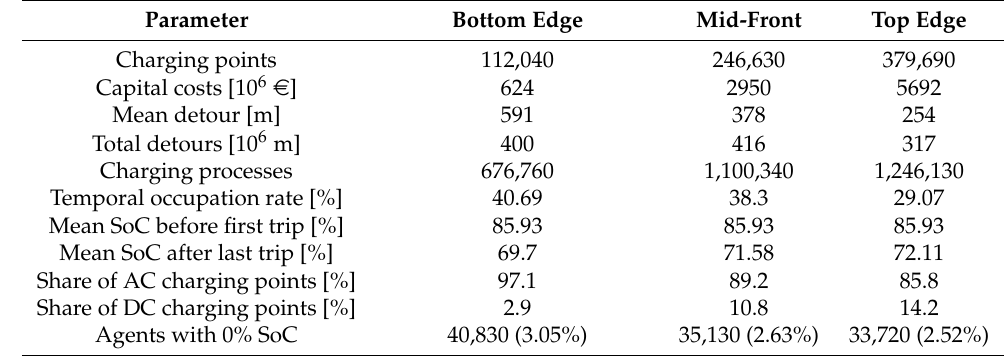
Table 6. Values of three different solutions of generation 100.